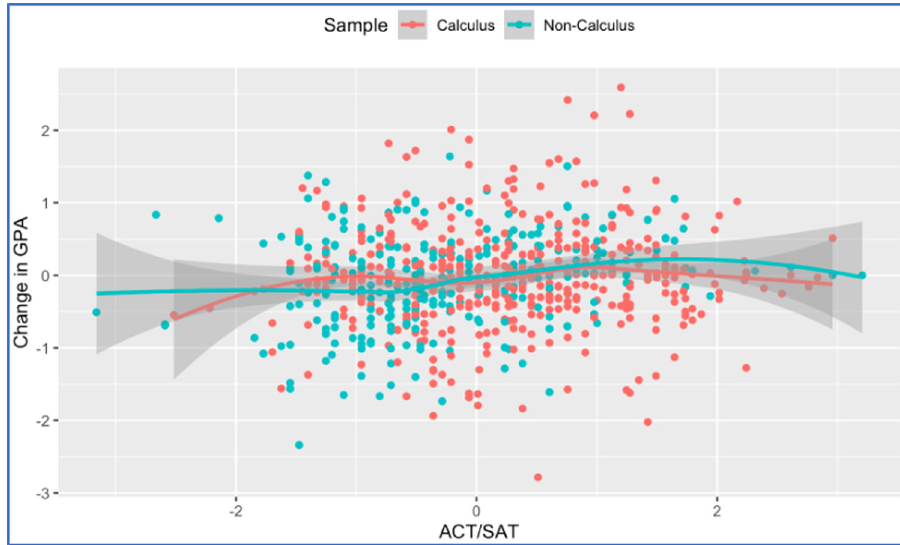
Fig 4. Relationship between GPA change and ACT/SAT scores by sample (calculus vs